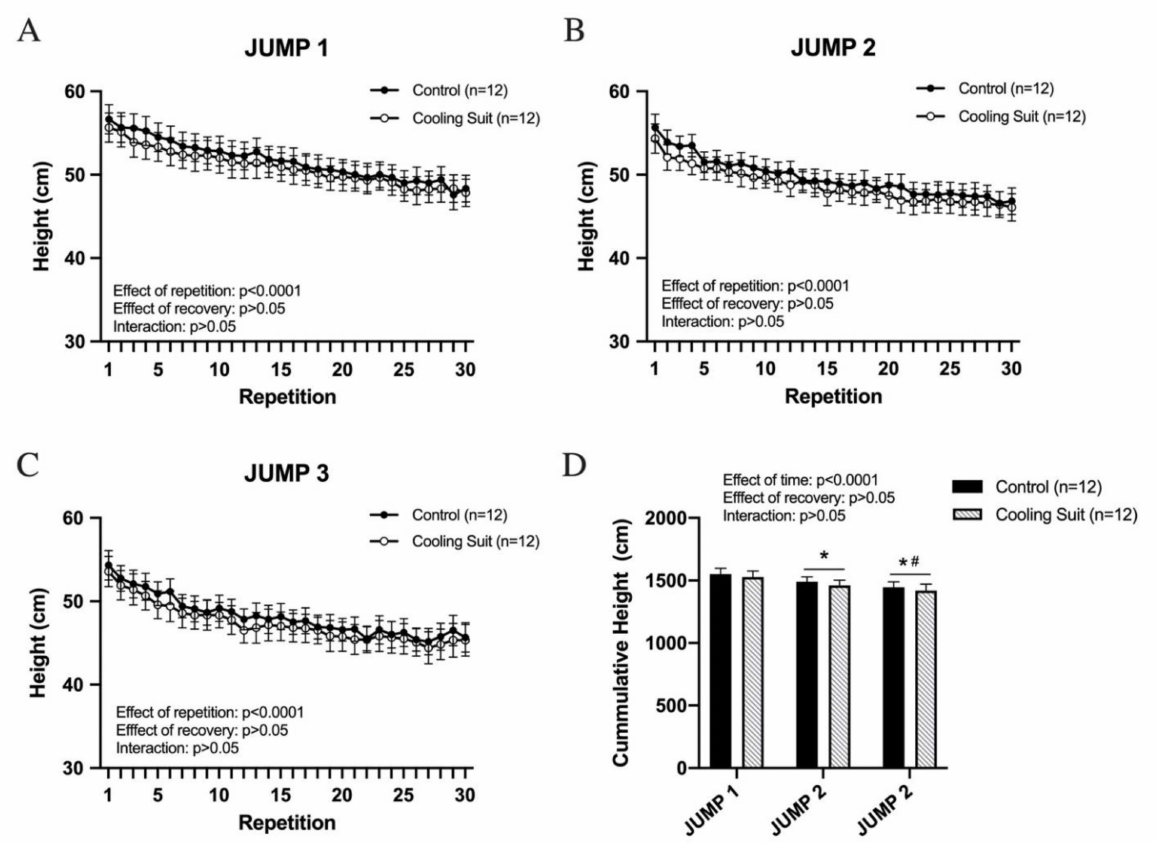
Figure 2. Vertical jump performance. Each set ( A – C ) consists of 30 consecutive vertical jumps. Cumulative jump height in each set is presented in ( D ). No significant differences were observed between the control group and the cooling suit group. * p < 0.05 vs. JUMP 1, # p < 0.05 vs. JUMP 2. Data are presented as the mean ±